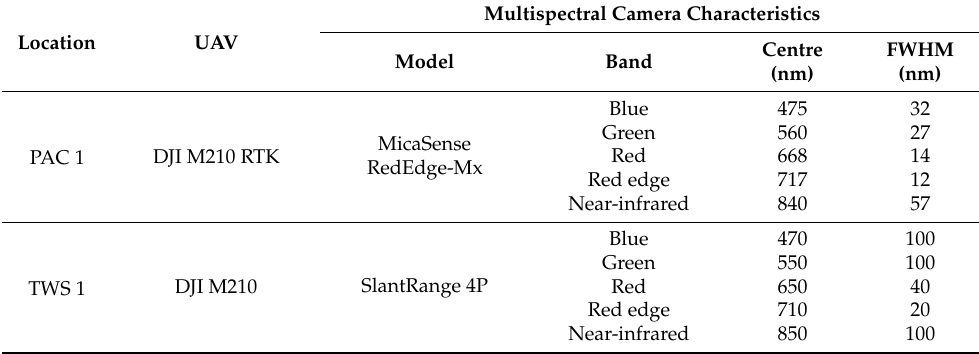
Table 1. Unmanned aerial vehicles (UAVs) and multispectral cameras used to perform flights in the two locations, with their respective characteristics of spectral bands, central wavelength, and full width at half maximum (FWHM).